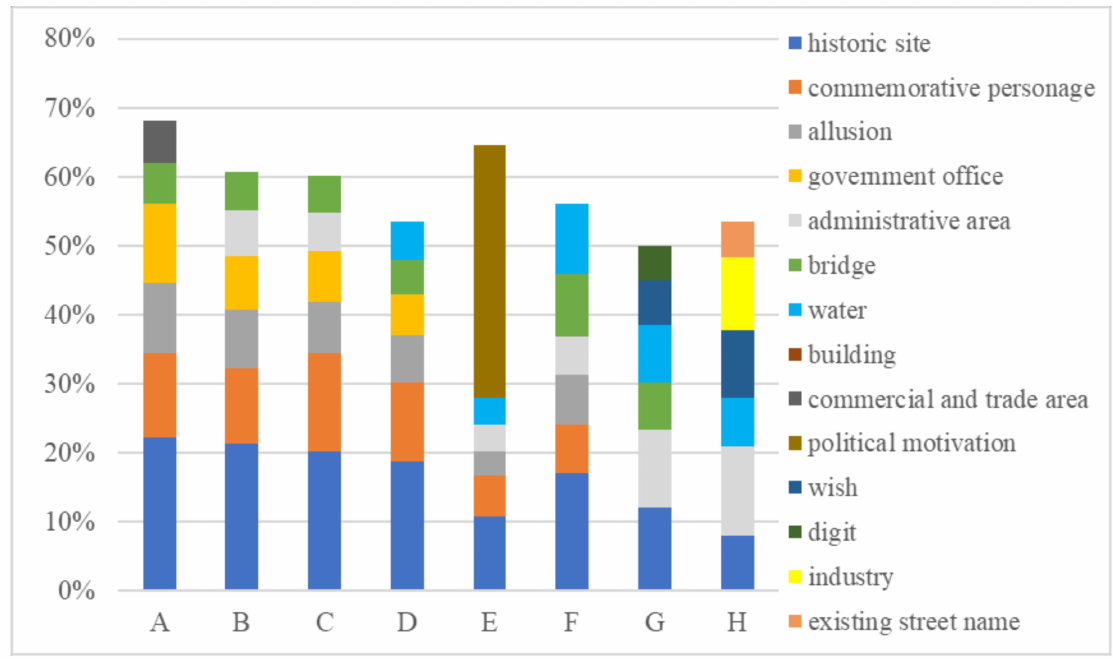
Figure 5. Proportion distribution of main street name types in each time